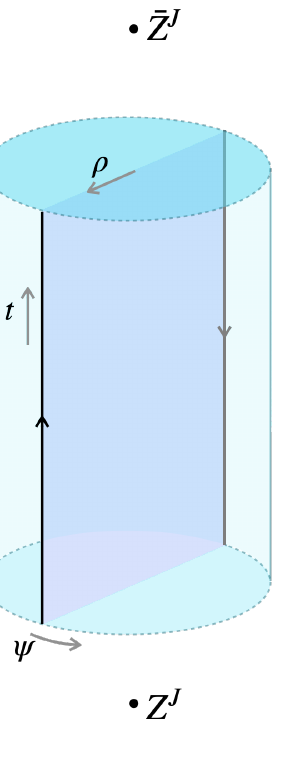
Figure 4 . The classical string solution in AdS 5 × S 5 dual to the Wilson loop operator with Z J and ¯ Z J . a. In global AdS coordinates, the string forms a strip stretching between the antipodal, 5 antiparallel lines forming the contour of the Wilson operator. The insertions, Z J and ¯ Z J , are located at the infinite past and future, respectively. b. In S 5 , the string wraps part of the upper half of the two-sphere Θ 2 + Θ 2 + Θ 2 = 1 . When the string is at the boundary of AdS, ρ → ±∞ , it is at 4 5 6 the north pole of the sphere, θ = 0 . When the string is in the center of AdS, ρ = 0 , it is at the maximum polar angle on the sphere, θ = θ . Furthermore, translations in t in AdS are accompanied 0 by rotations in φ on the